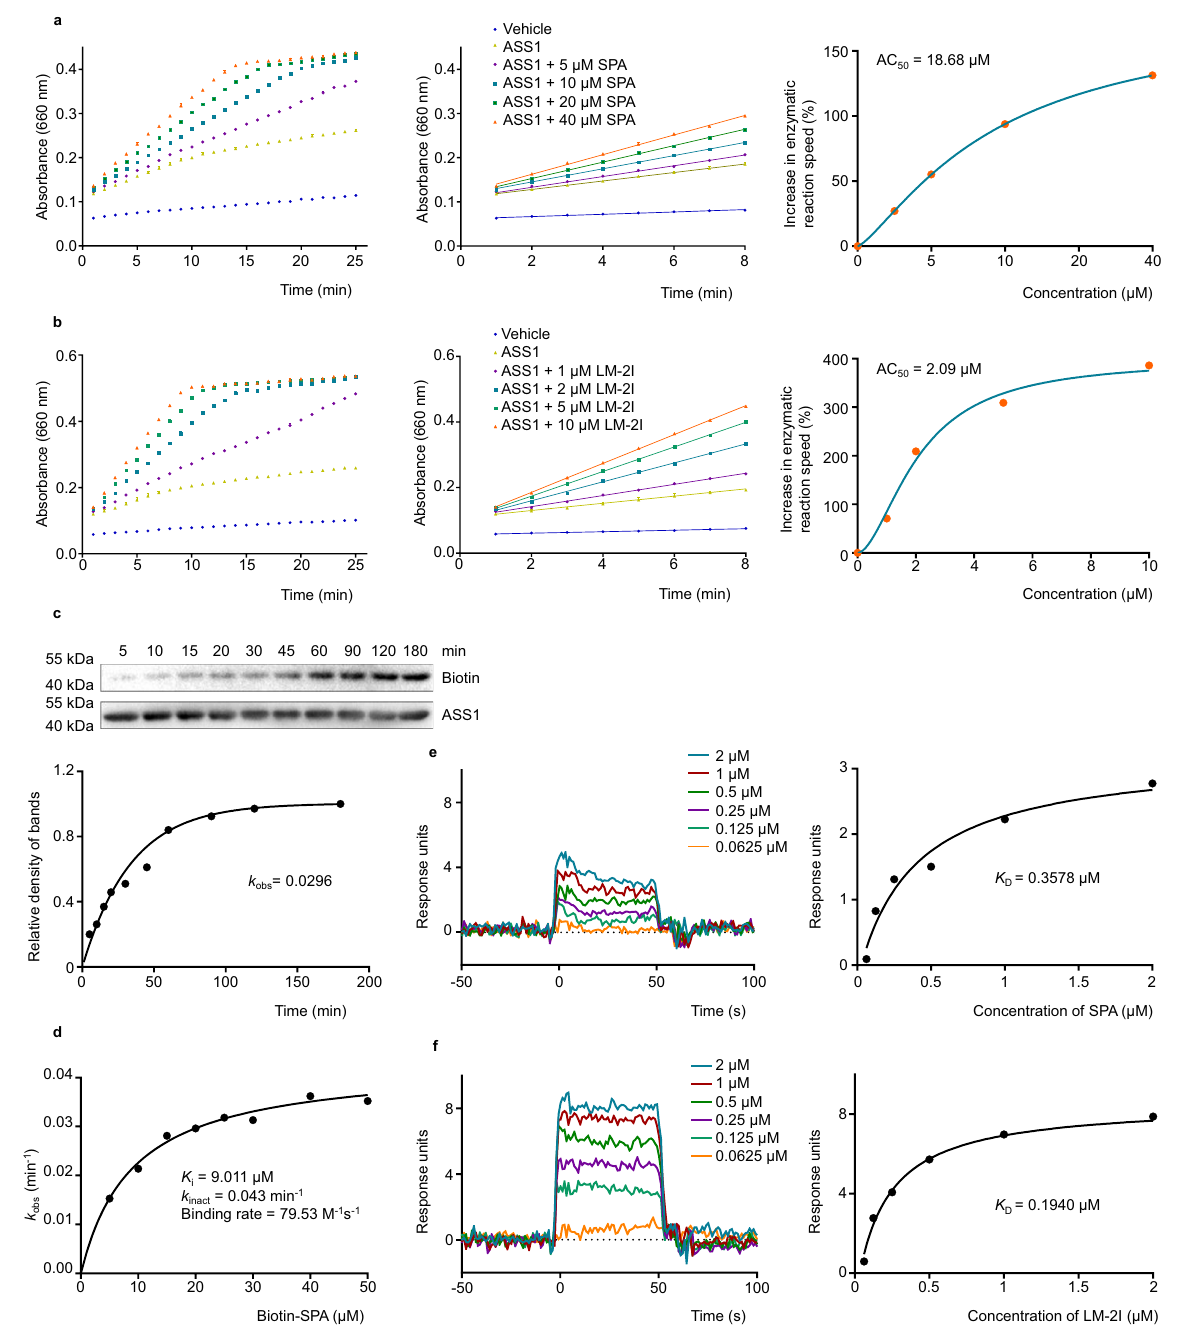
Fig. 4 SPA and LM-2I enhance ASS1 catalytic activity and its kinetics. The recombinant ASS1 protein was incubated with different concentrations of SPA ( a ) or LM-2I ( b ) overnight, and the ASS1 catalytic activity was measured. The initial increase in absorbance at 660 nm (A 660 ) between 1 and 8 min is expanded in the middle panel. In the right panel, the Hill 1 model of Origin 2018 software was used to analyze the increase in enzymatic reaction speed at different concentrations. The maximal activation ratio and AC 50 were calculated. (mean ± s.d.). c The determination of k obs for the interaction of ASS1 (0.5 µ M) with Biotin-SPA (20 µ M) was calculated at different time points ( n = 3 biologically independent experiments). d Plotting the k ASS1 (0.5 µ M) with different concentrations of Biotin-SPA. BIAcore diagram (left panel) and K D (right panel) of the recombinant ASS1 protein binding to SPA ( e ) or LM-2I ( f ).Source data are provided as a Source Data fi le.